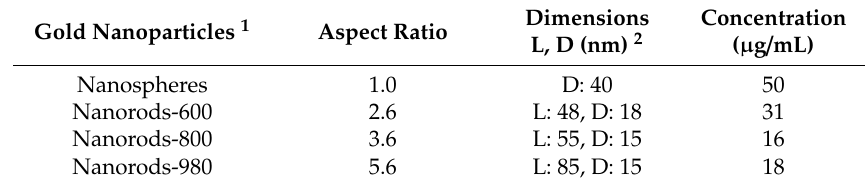
Table 1. Summary of citrate stabilized gold nanoparticles used in our studies. Gold Nanoparticles 1 Aspect Ratio